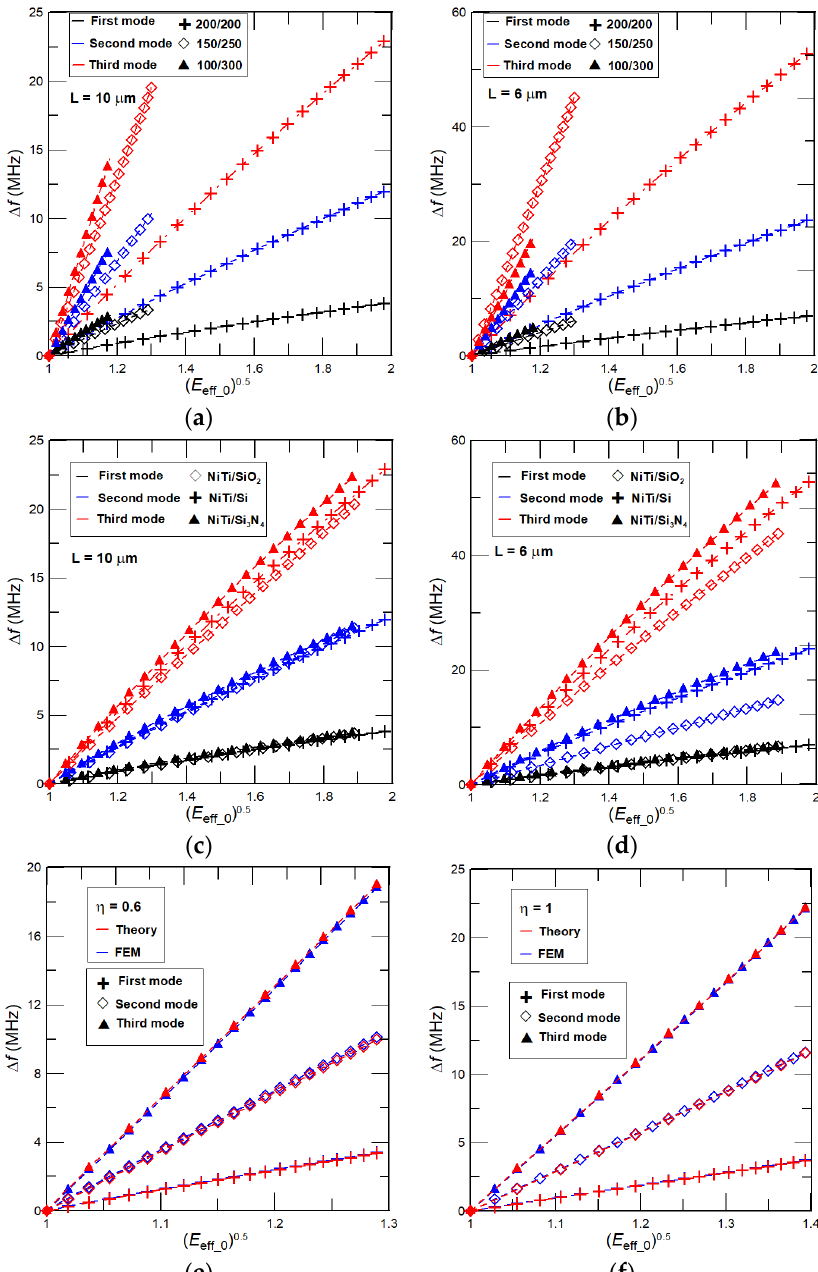
Figure 6. Absolute frequency shift Δ f as function of ( E eff_0 ) 0.5 calculated for NiTi/Si nanocantilever of η = 0.33, 0.6, and 1, and length ( a ) L = 10 μ m and ( b ) L = 6 μ m. Dependency of Δ f on ( E eff_0 ) 0.5 for NiTi/Si, NiTi/SiO 2 , and NiTi/Si 3 N 4 nanocantilevers of η = 1 and ( c ) L = 10 μ m and ( d ) L = 6 μ m; σ 0 = 1 to 5. Comparisons of Δ f on ( E eff_0 ) 0.5 predicted by present analytical model and FEM for NiTi/Si